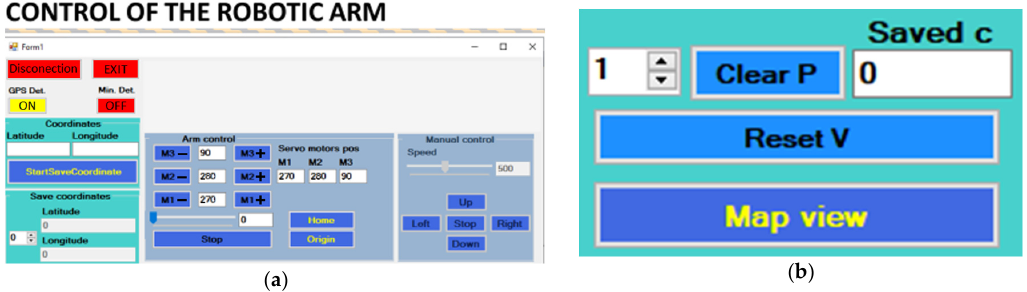
Figure 7. Configuring the control panel: ( a ) robotic arm control with servo motors; ( b ) manual control.